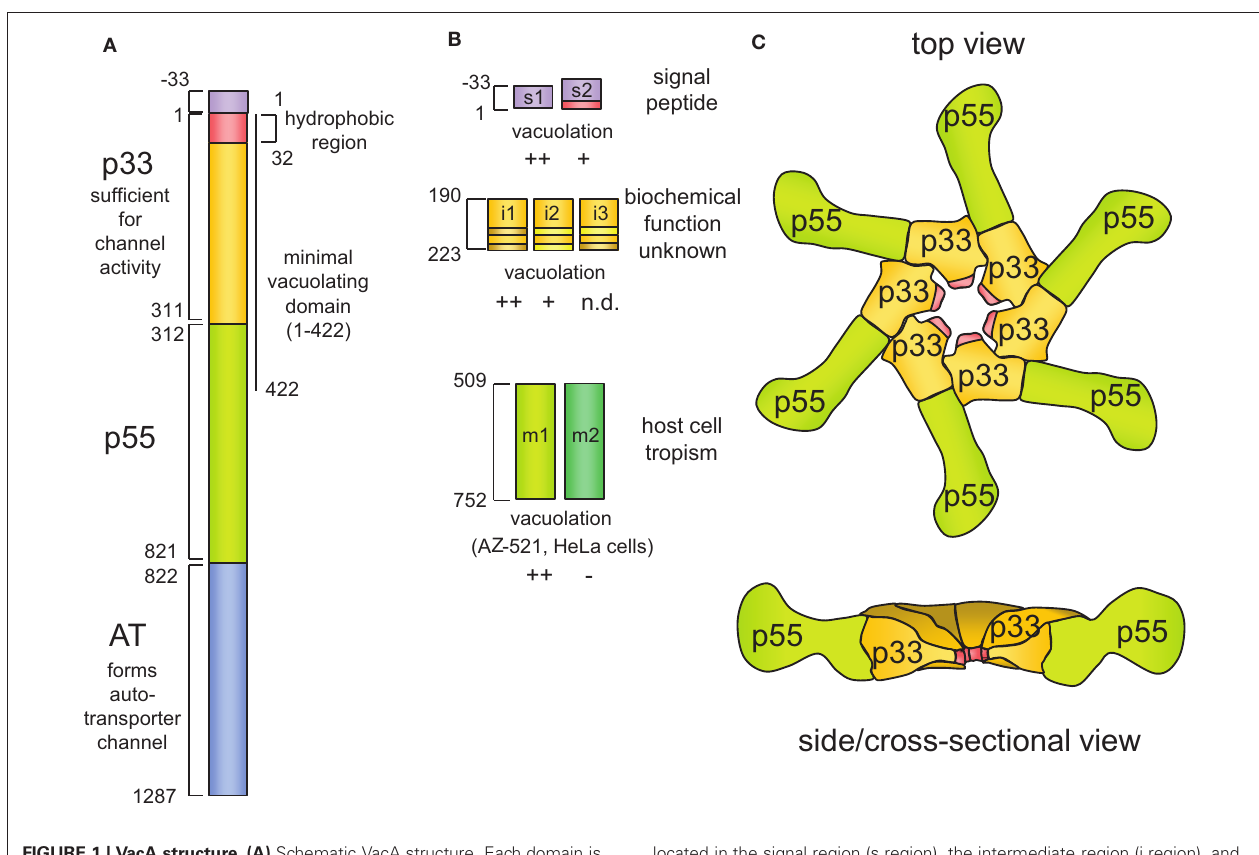
FIGURE 1 | VacA structure. (A) Schematic VacA structure. Each domain is denoted by a different color and by the first and last amino residue of that particular domain. The name of each domain is denoted in bold, and its function (if known) is described. (B) The polymorphic nature of the vacA gene is emphasized by highlighting the three major allele families, which are